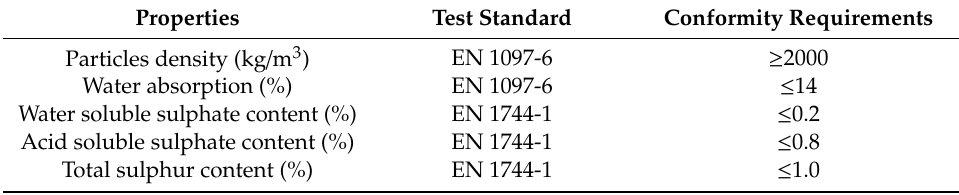
Table 6. Properties and minimum conformity requirements of FRA for all